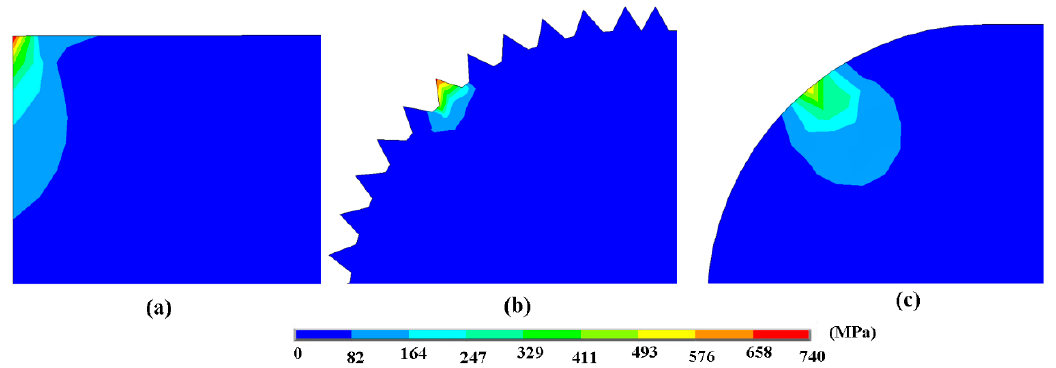
Figure 17. Contact stress distribution of silicon particles at the contact areas: ( a ) Chemical etching model; ( b ) mechanical honing model; ( c ) laser finishing model.